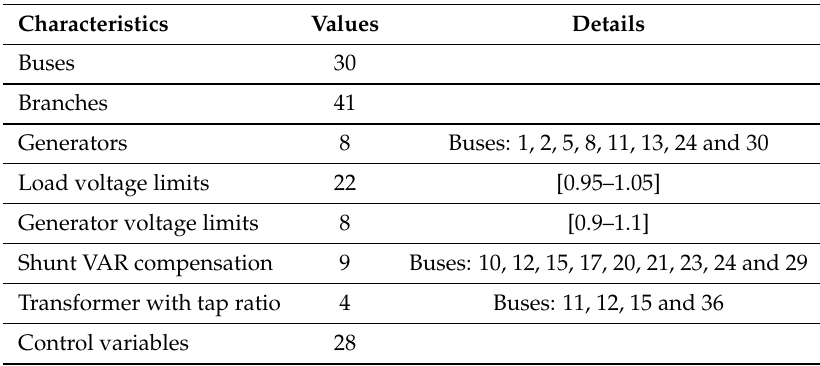
Table A1. The general specifications of the IEEE 30-bus modified